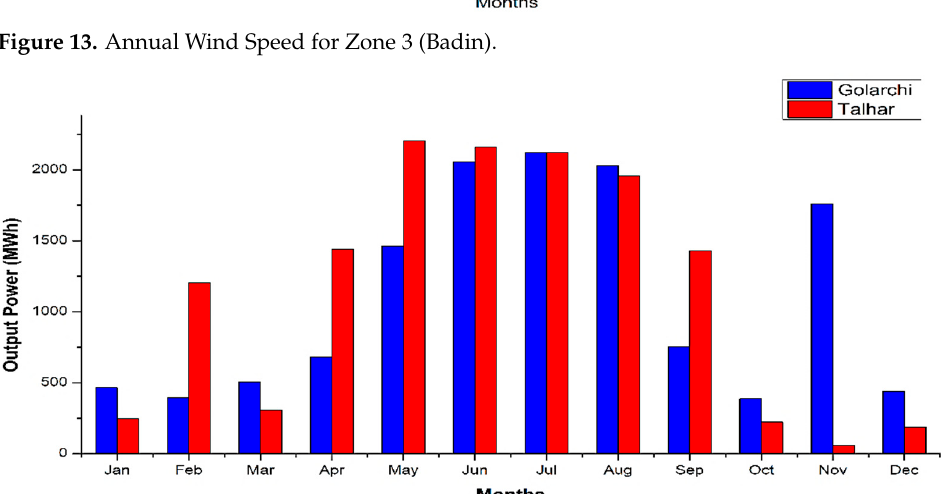
Figure 14 . Power output in MWh for Zone 3 (Badin).